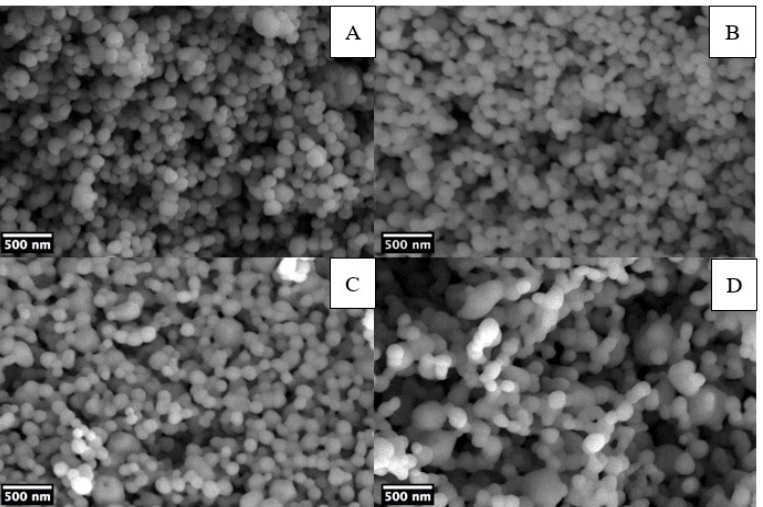
Figure 5. SEM micrographs of BT particles in hydrothermal conditions at different processing times: 2 h ( A ), 4 h ( B ), 6 h ( C ), and 8 h ( D